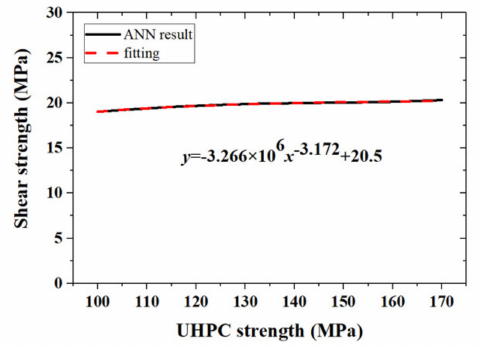
Figure 8. Correction factor c 0 ( f UHPC ) .